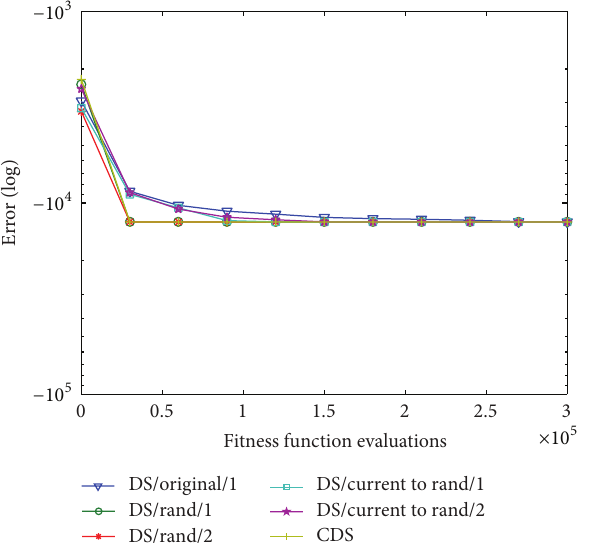
Figure 9: Comparison of performance of six algorithms for mini- mization of 𝑓 10 with dimension 30.